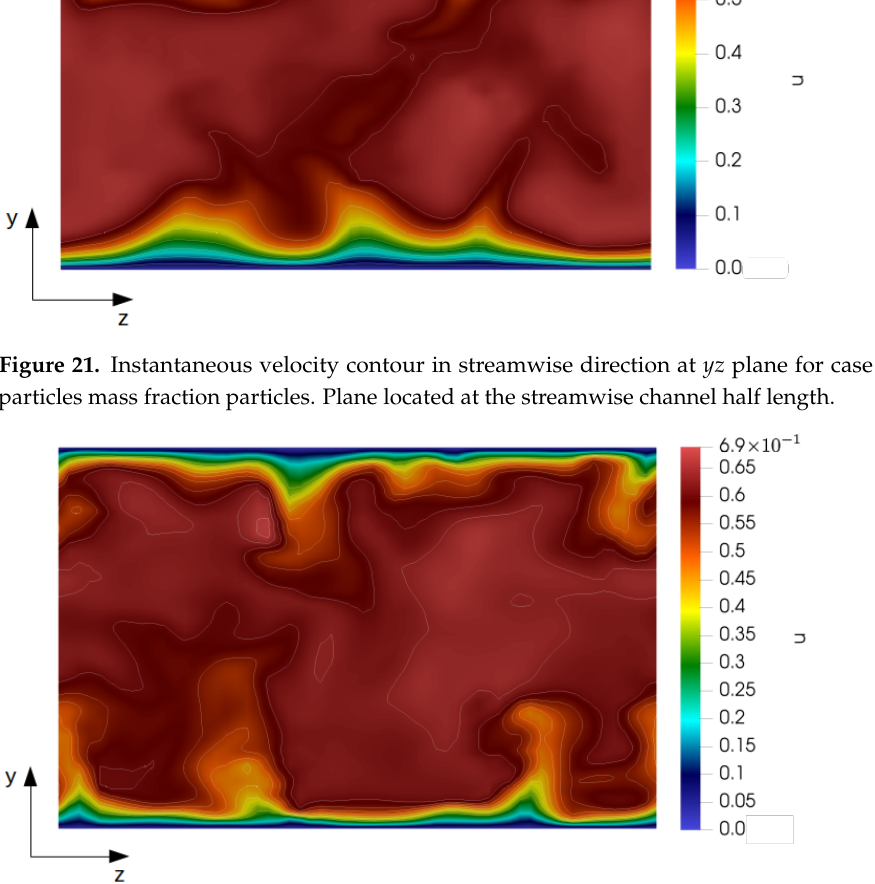
Figure 22. Instantaneous velocity contour in streamwise direction at yz plane for case with low particles mass fraction